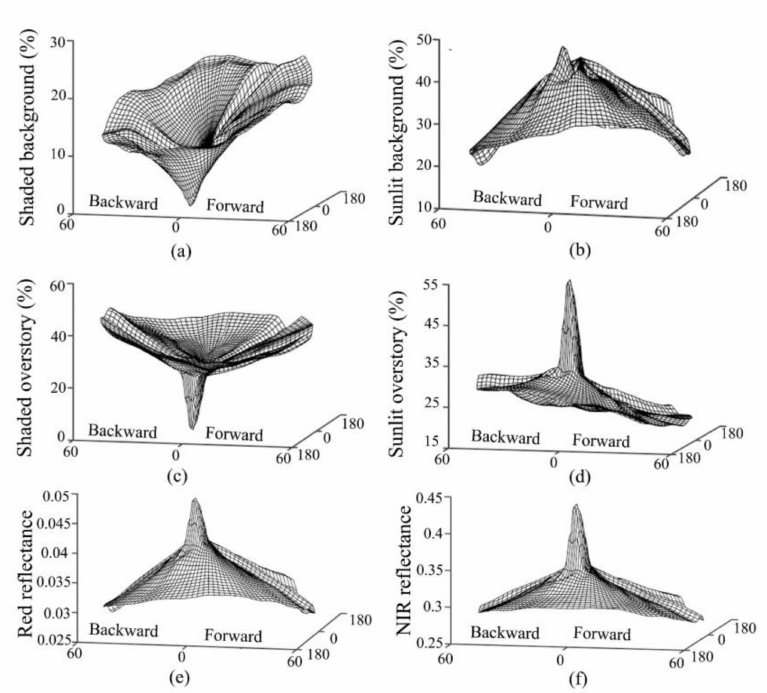
Figure 9. The spatial distributions of the ALS-based four forest component proportions (insets a – d ) and forest canopy reflectance in red (inset e ) and near-infrared (inset f ) bands for forest plot WPA-P2 with the solar zenith and azimuth angles of 37 ◦ and 150 ◦ ,